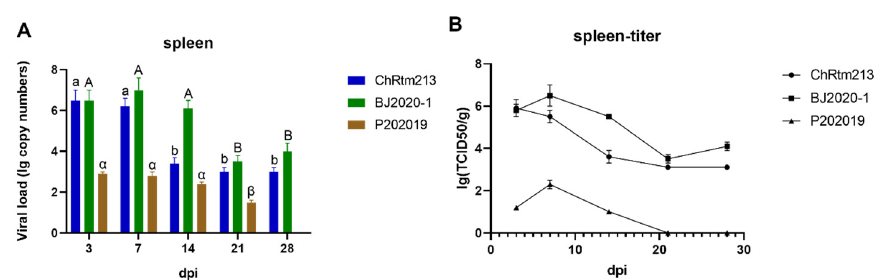
Figure 7. IPNV virus loads in the spleen were sampled on 3, 7, 14, 21, and 28 dpi. ( A ) Replication kinetics of IPNV-infected rainbow trout. Samples were obtained in triplicate. Total RNA was extracted and analyzed by qPCR. Error bars represent the SD from triplicate within an experiment. Different letters of the same class indicated the statistical significance, p < 0.05. a, b indicated that the viral load of IPNV-ChRtm213 was significantly different at different sampling time points, p < 0.05. A, B indicated that the viral load of IPNV-BJ2020-1 was significantly different at different sampling time points, p < 0.05. α , β indicated that the viral load of IPNV-P202019 was significantly different at different sampling time points, p < 0.05. ( B ) The detection of viral titers in the spleen of IPNV-infected rainbow trout.